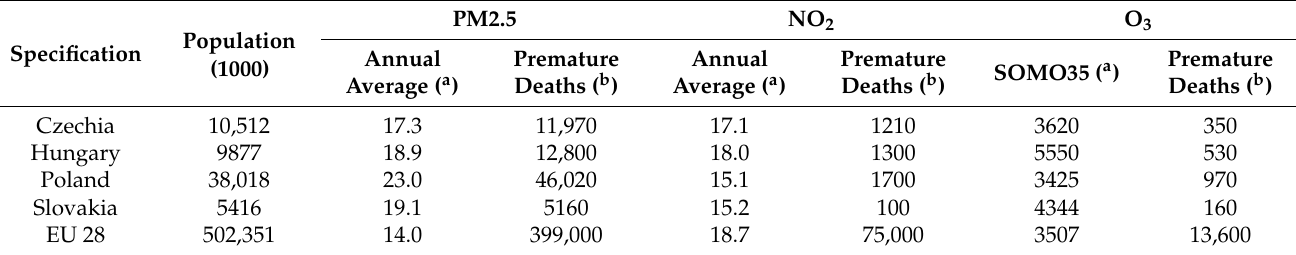
Table 5. Premature deaths related to exposure to PM2.5, NO 2, and O 3 in the Visegrad Group countries in 2015. Reproduced from [20], European Environment Agency: